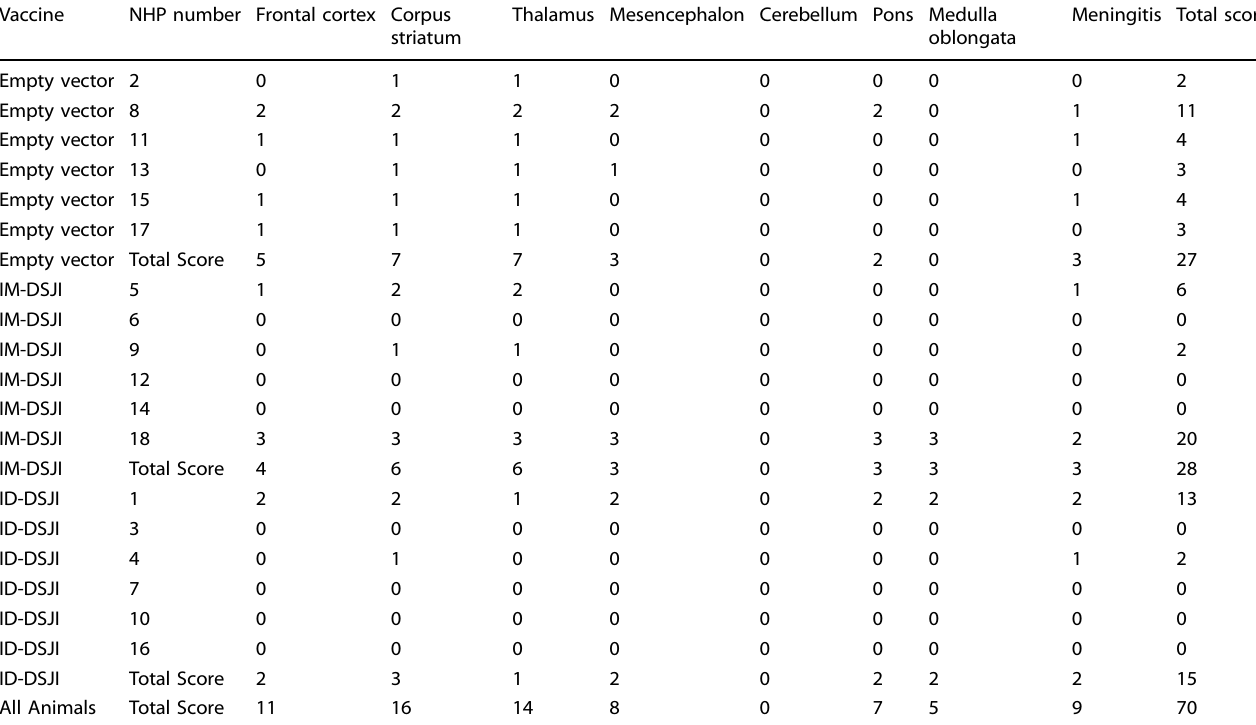
Table 1. Pathology scores of isolated brain sections.